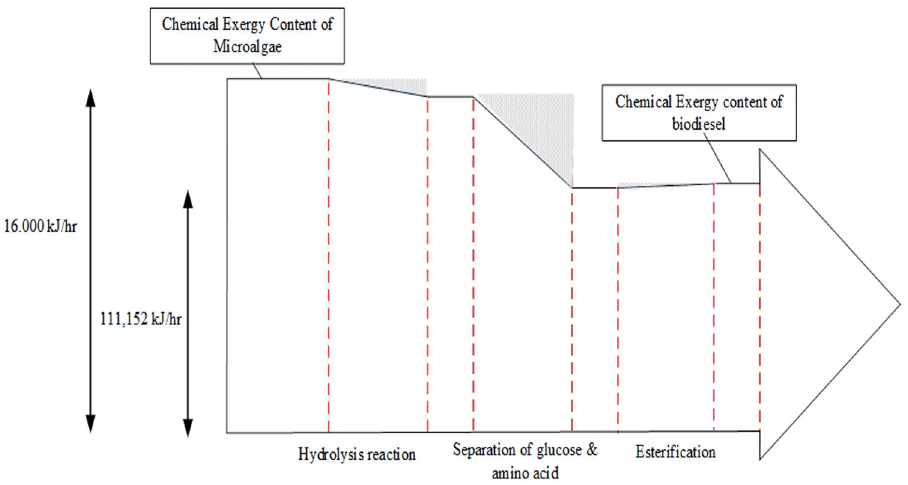
Figure 7: Biodiesel production process fl ow diagram of HTL - esteri fi cation